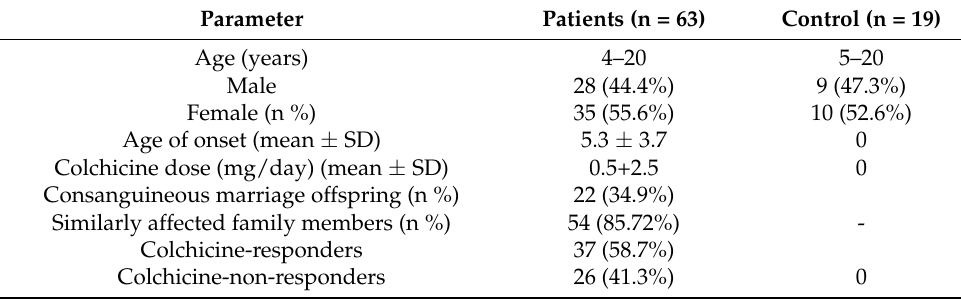
Table 1. Demographic data of the study population.